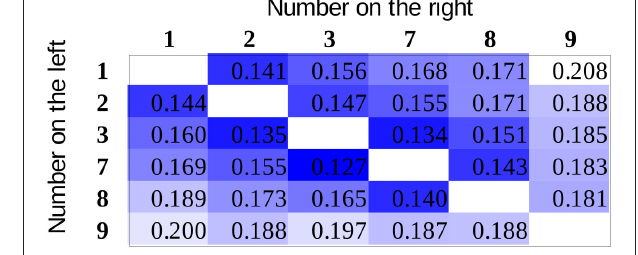
FIGURE 5 | Drift rate values in the whole stimulus